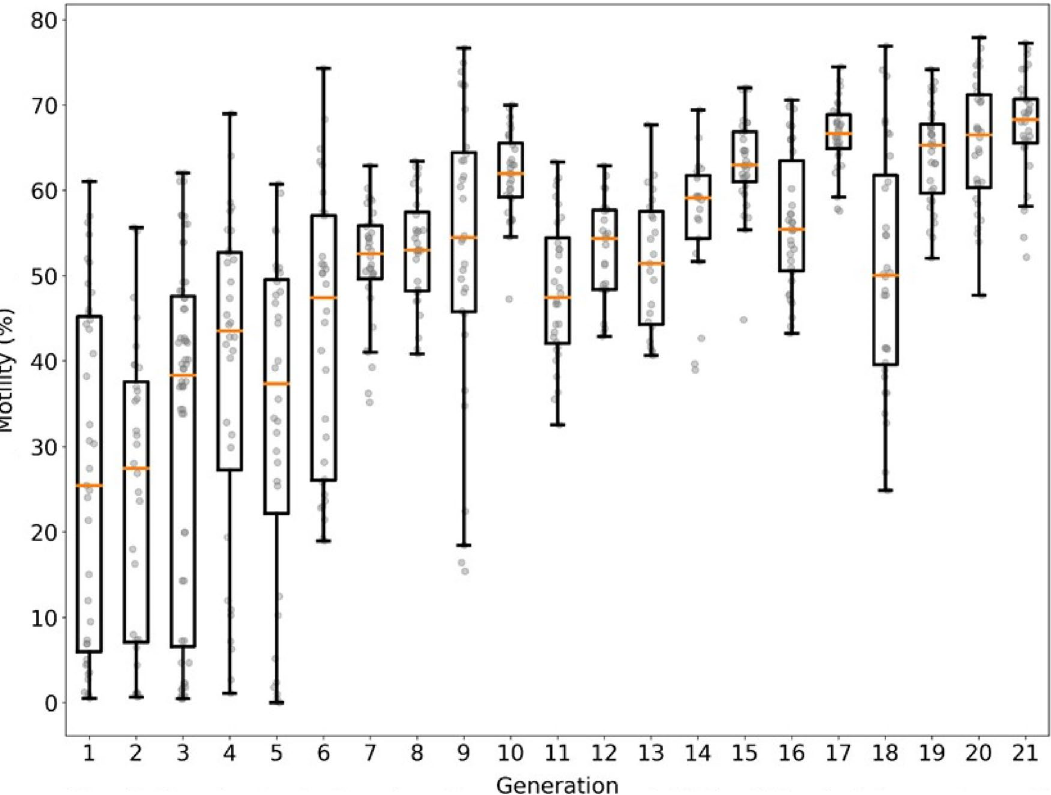
Figure 3. Generational results for total motility metric (generation 1–14, 16, and 17) and relative post thaw motility metric (generation 18–21). Generation 1 to 17, 18, to 21 correspond to extender compositions generated by differential evolution. Generation 15 corresponds to re-testing of the top performing extenders from generation